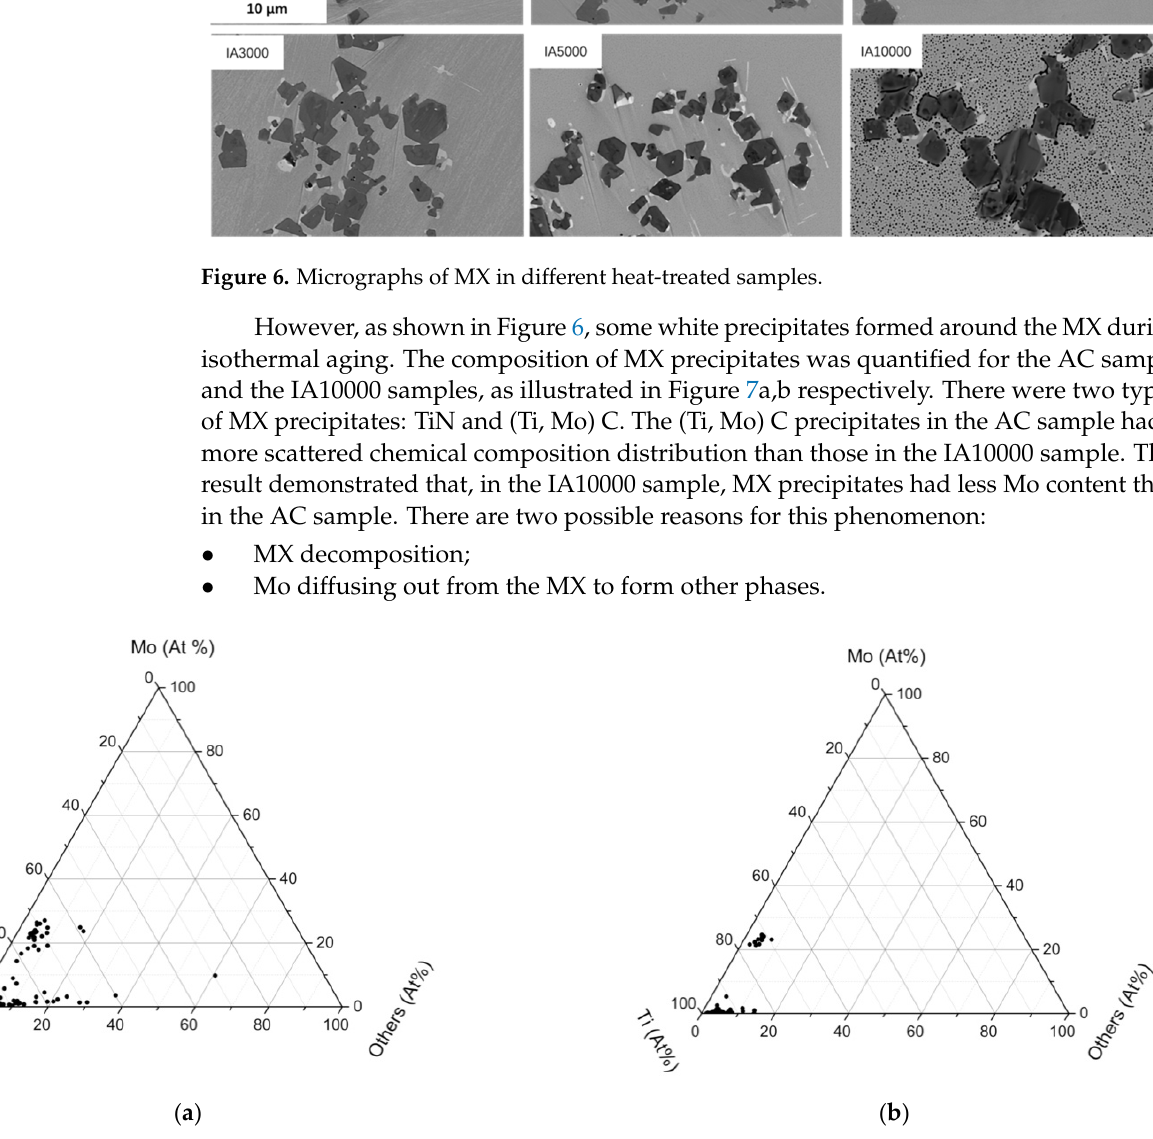
Figure 7. Compositional quantification of MX: ( a ) AC sample and ( b ) IA10000 sample.